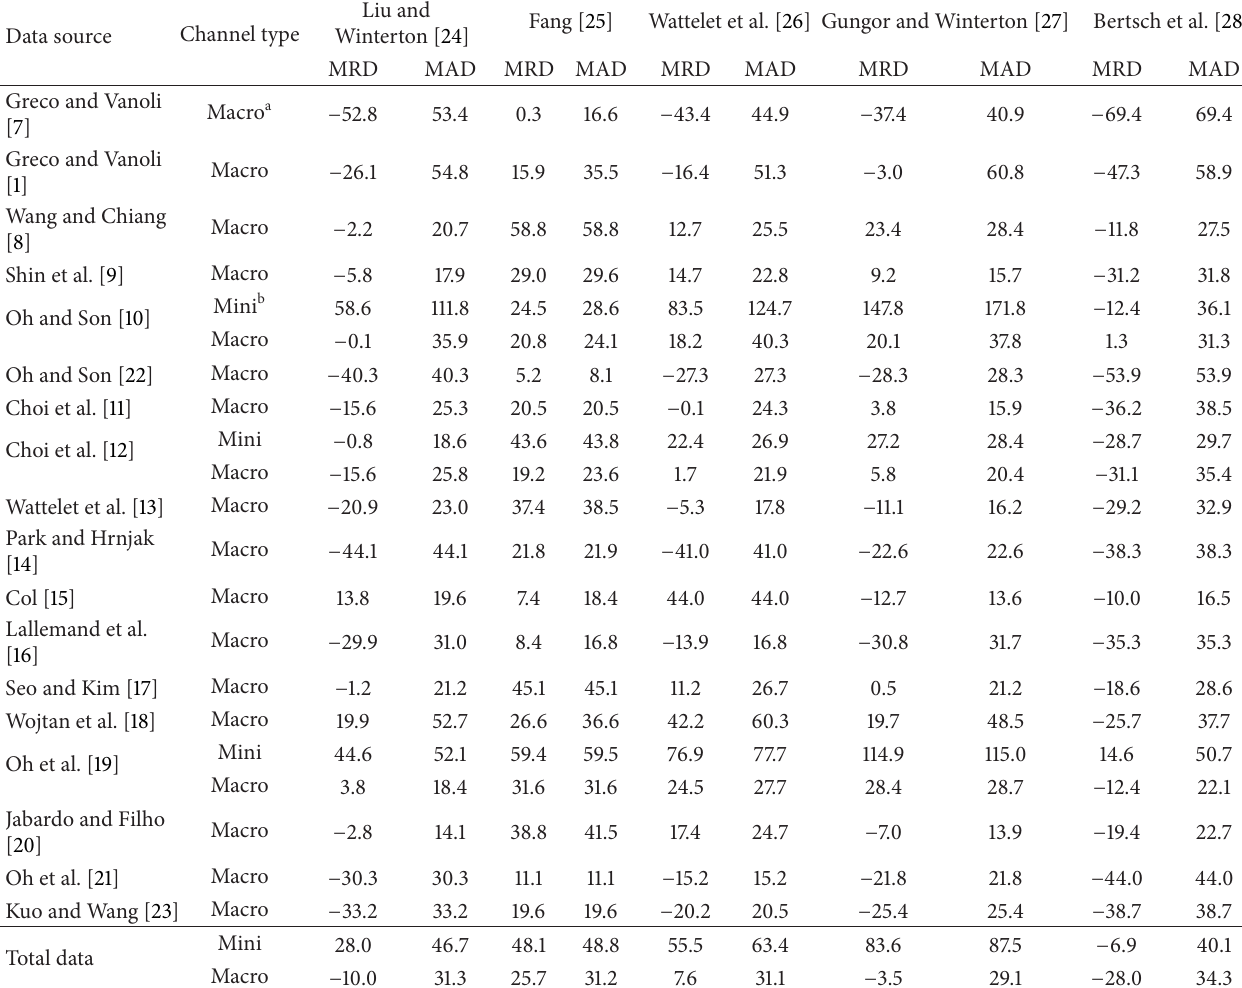
Table 4: Deviation of the top 5 correlations for different channel dimensions by Li and Wu method